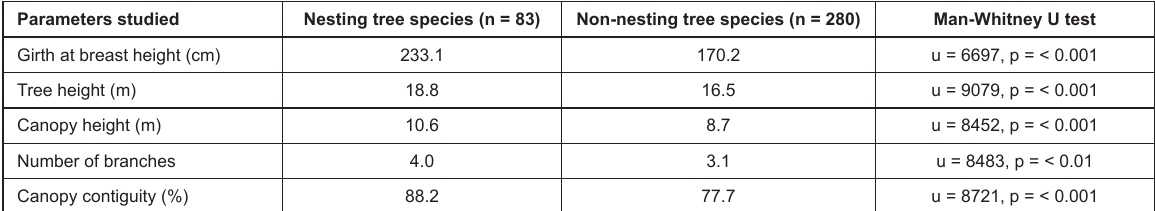
Table 3. Mean measures of various parameters studied for nest and non-nest trees and their statistical significance Parameters